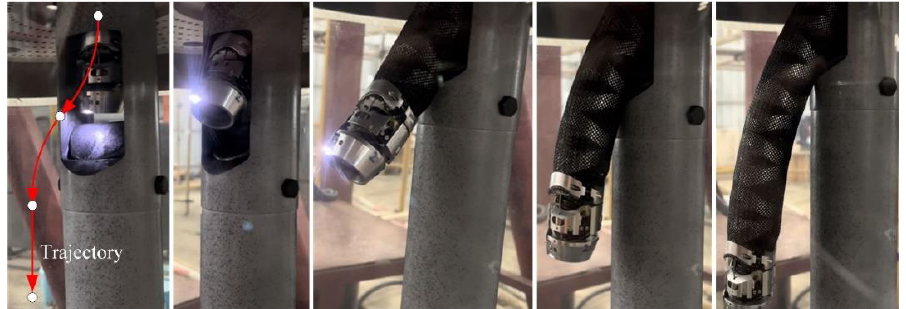
Figure 11. Trajectory for passing through the divider plug.